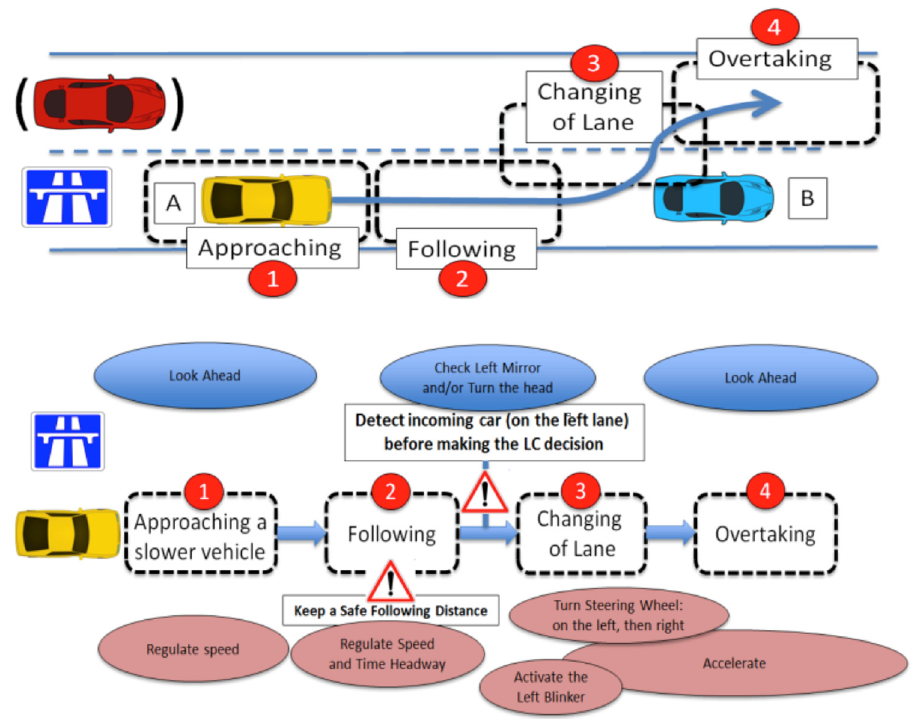
Figure 5. Driving activity modeling and examples of expected behaviors when changing lane on